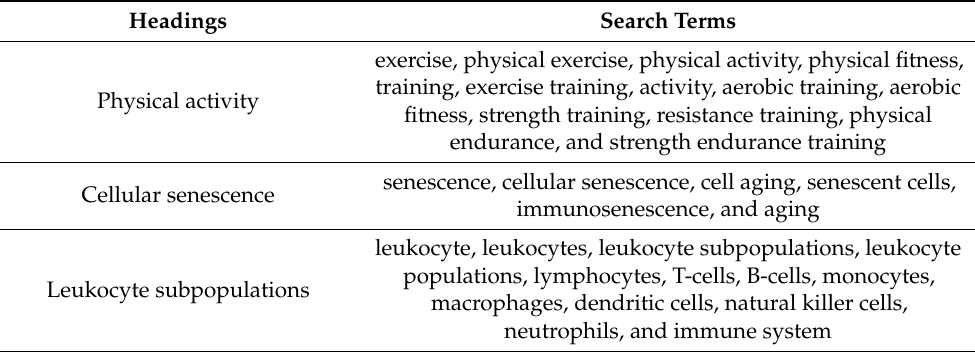
Table 2. Overview of the search terms used for this systematic